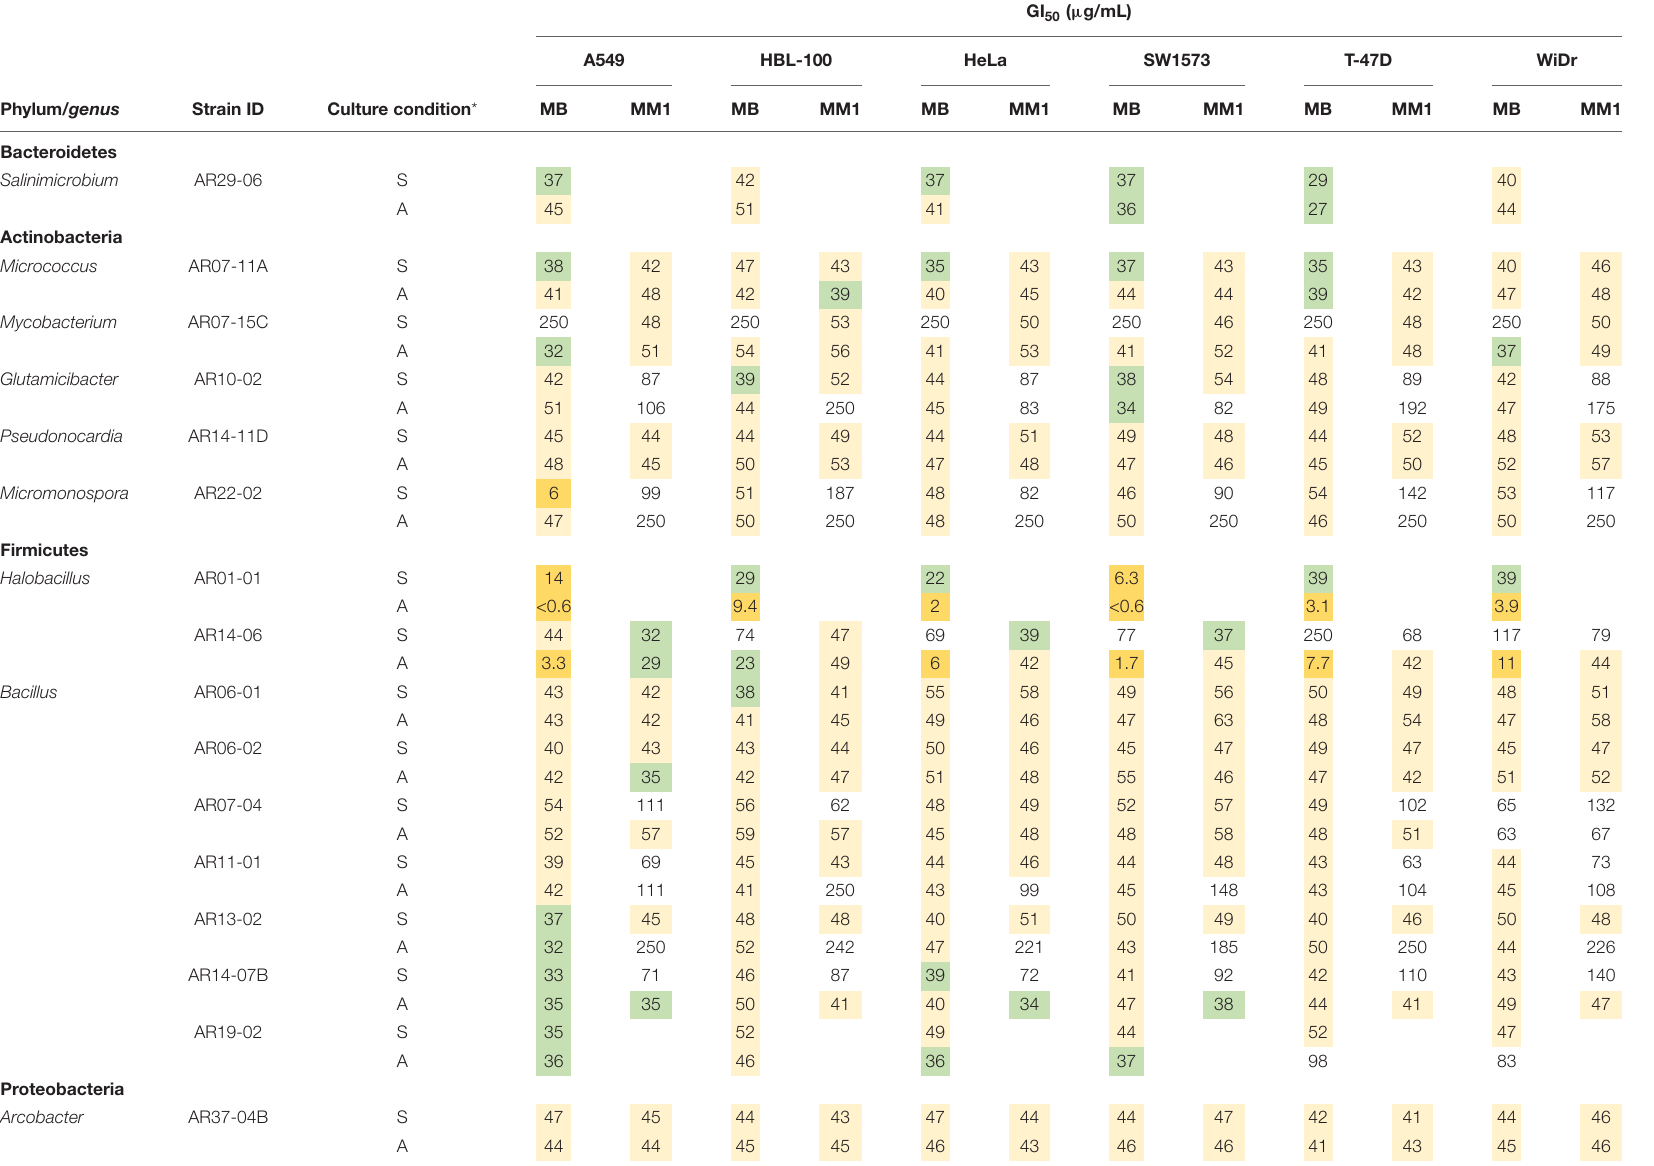
TABLE 2 | Antiproliferative activity of 33 selected bacterial strains isolated from environmental samples of Tagoro submarine volcano against human solid tumor cell